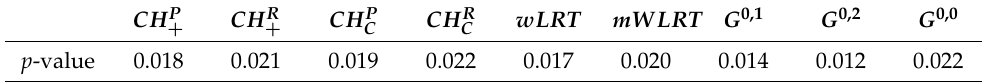
Table 7. p -values of the tests for the head-and-neck cancer data. wLRT mWLRT G 0,1 G 0,2 G 0,0 CH P + CH R + CH P CH R C C p -value 0.018